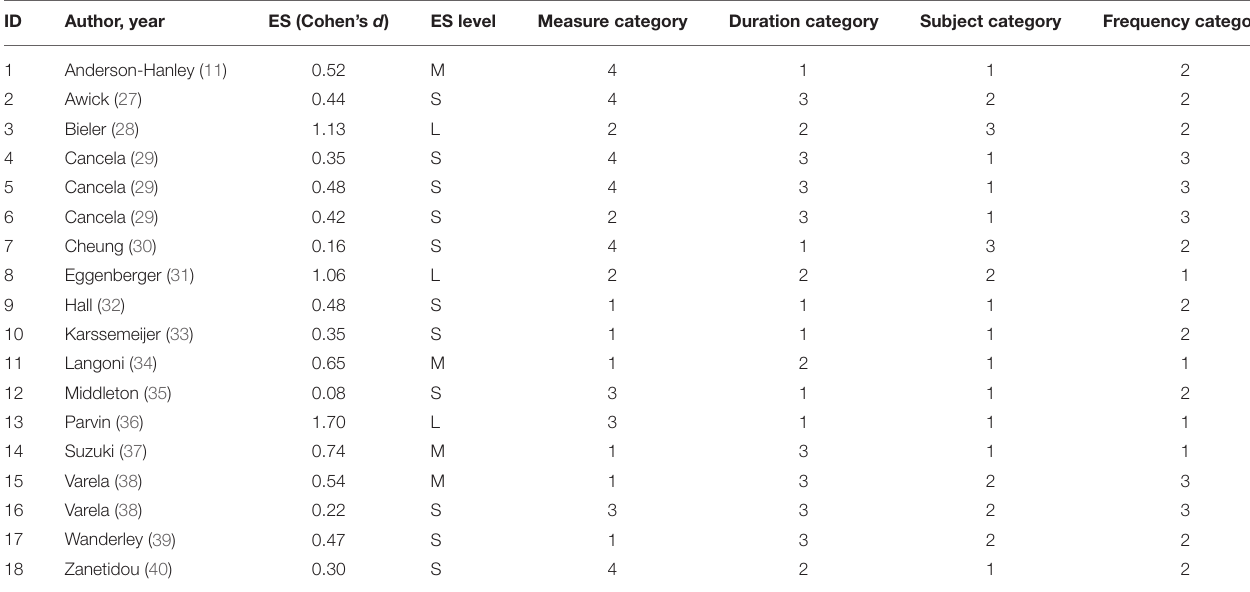
TABLE 2 | Inclusion of study effect sizes and classification of